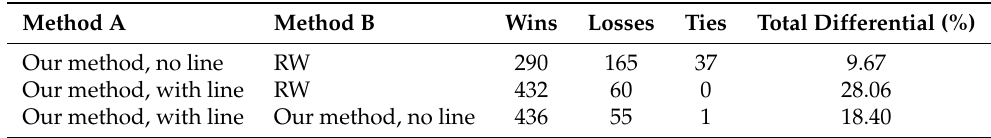
Table 3. Dataset 1 [4]: pairwise comparison of methods with the Jaccard index. A win indicates that method A outperformed method B on one frame.